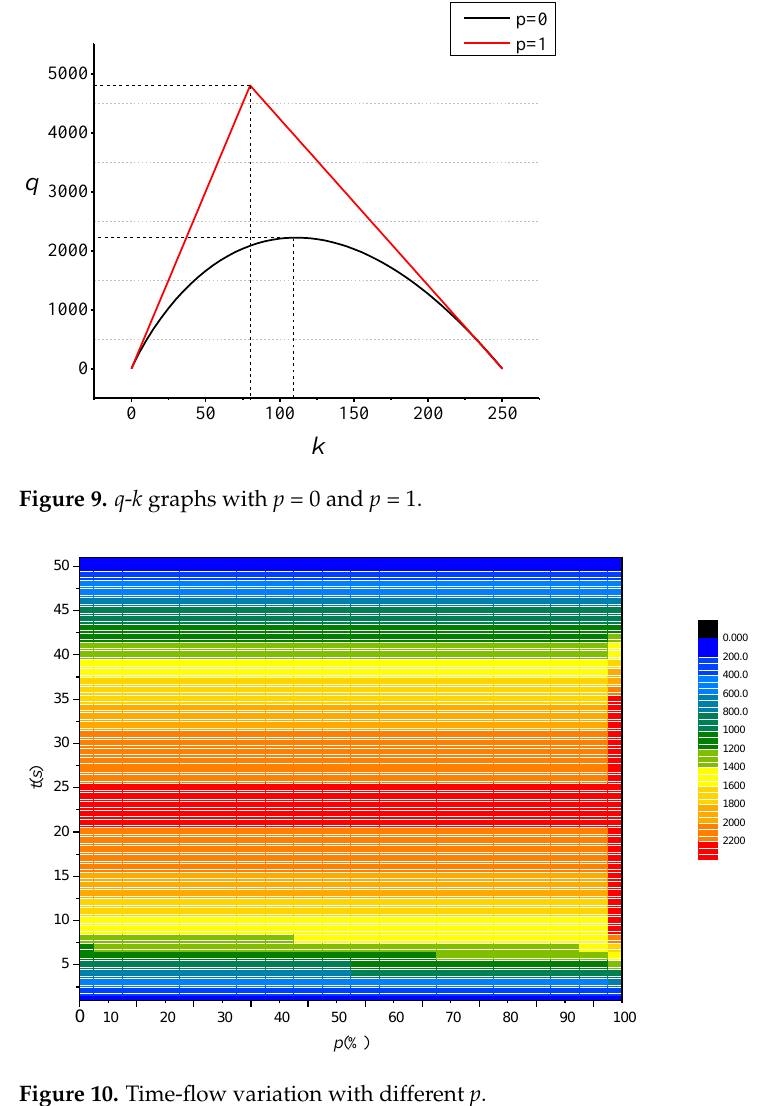
Figure 10. Time-flow variation with different p. Table 4. Partial data of q when p takes different Table 4. Partial data of q when p takes different values.